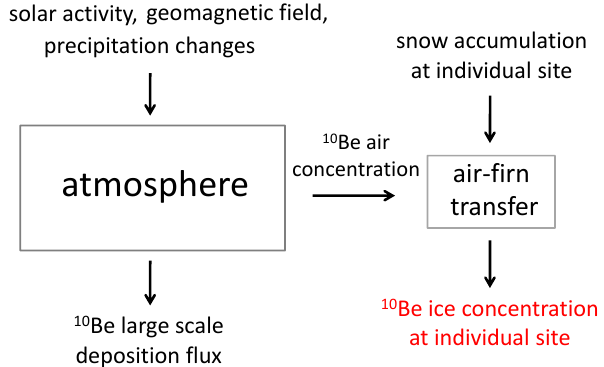
Figure 6. Sketch of our basic model approach to simulate 10 Be ice core records on the glacial–interglacial timescale. The model setup of the atmosphere is presented in Sect. 2.1, whereas the air– firn transfer model is put forward in Sect. 2.2. Model input records are discussed in Sect.